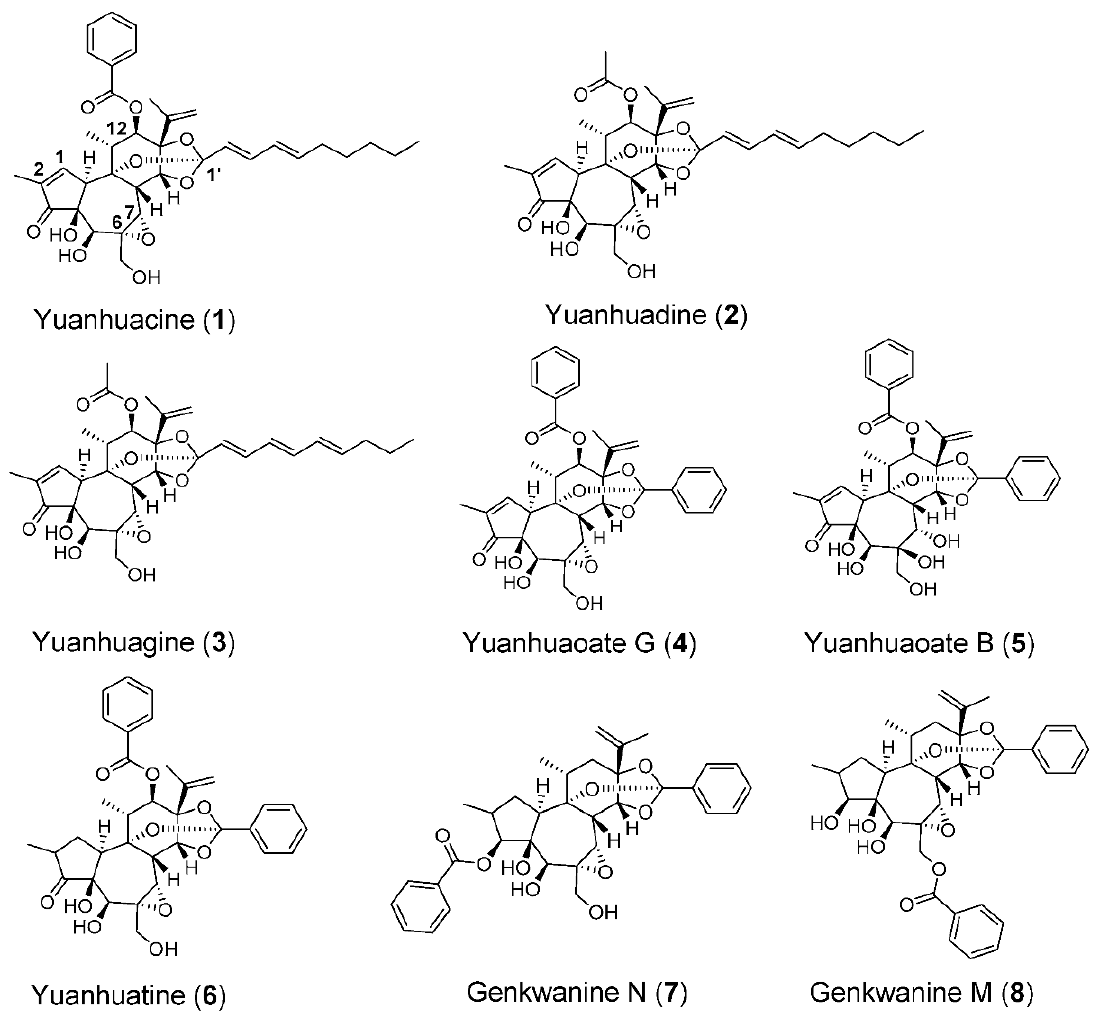
Figure 2. Structures of daphnane type diterpenoids identified in this study. Table 1. Potency of 1 for the inhibition of TBNC cell growth (IC 50 ) or the differentiation of THP-1 cells (EC 50